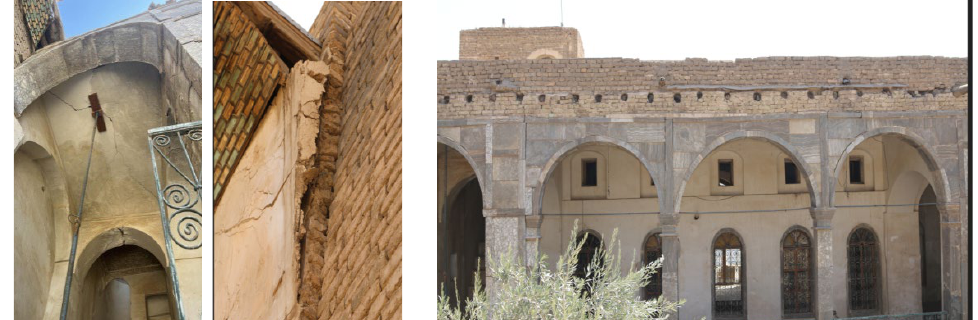
Figure 13. Structure in the façades of Rashid Agah House (photos taken by authors).